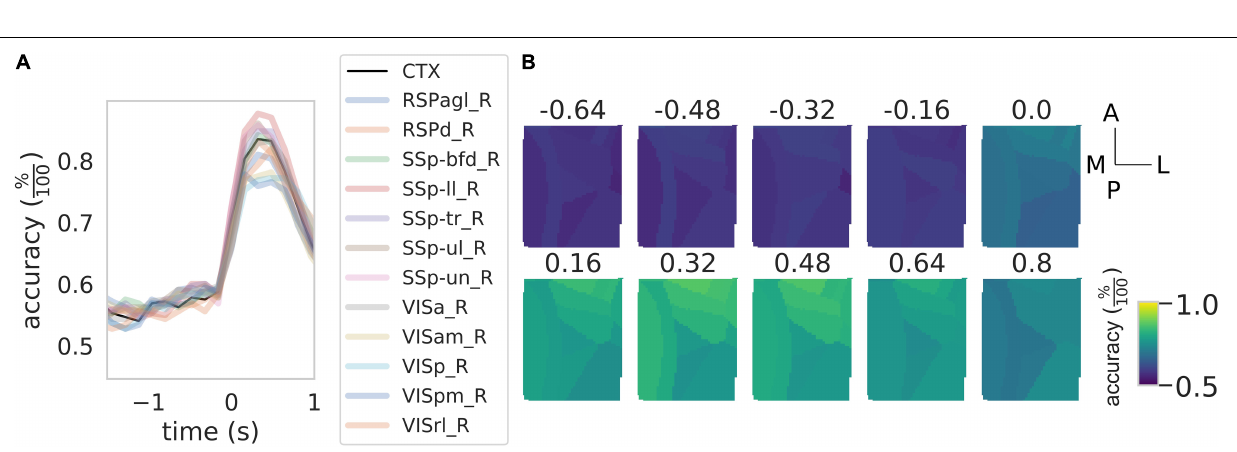
FIGURE 4 | Rewarded pull can be used to discriminate between healthy control and stroke subjects. (A) Time course of the accuracy of the discrimination between control and stroke subjects as a function of the time window considered. Black solid line represents the result of the discrimination over the entire field of view while the shaded colored lines represent the result for the same classification for the 12 cortical parcels in the field of view. See Figure 3 for the definition of the x -axis. (B) Time course of the accuracy as a function of the time window for the 12 areas in the field of view. Scale bars at the far right are 1 mm in